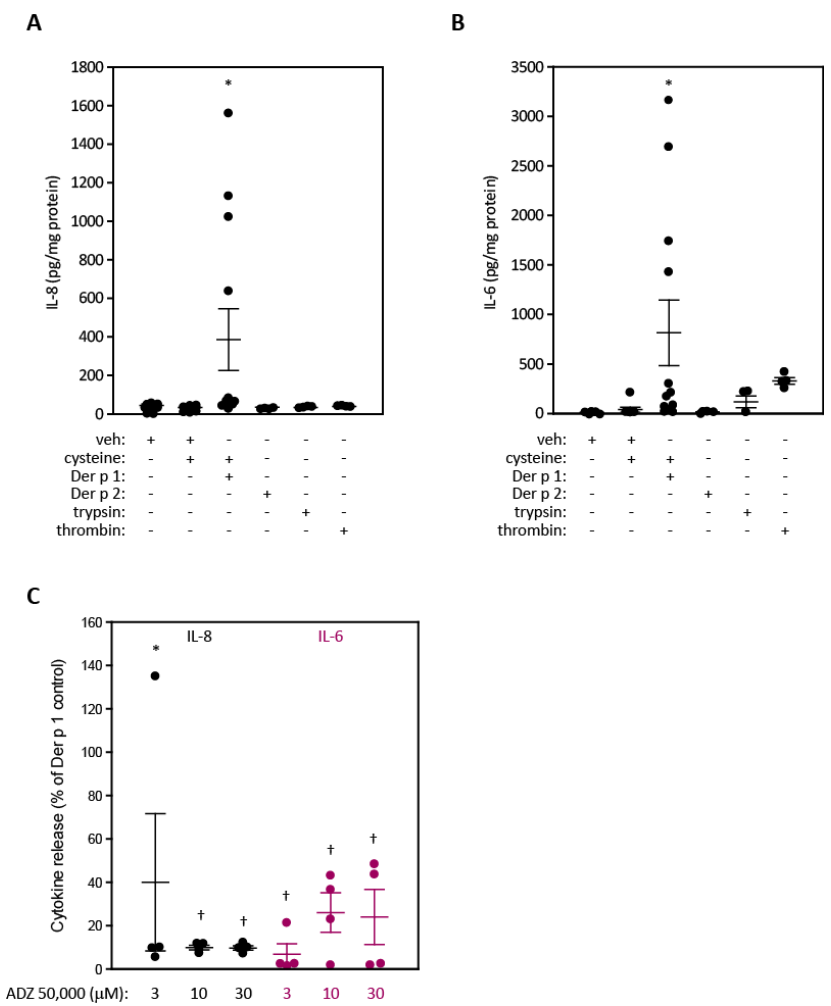
Figure 3. Release of IL-8 or IL-6 from cultured A549 cells and the effect of ADZ 50,000. ( A , B ) Release of IL-8 or IL-6 following stimulation by Der p 1 (20 nM), Der p 2 (14 nM), TPCK-treated trypsin (9 nM), or thrombin (0.5 U/mL) all applied apically. Cells were exposed for 8 h to serum-free EMEM containing the treatments, supplemented with 5 mM cysteine in the case of Der p 1. Cells were then washed and incubated with serum-free EMEM alone for a further 16 h prior to collection of samples. Data are shown as results from individual experiments with cells of different passage number. * p < 0.05 vs. vehicle treatments in experiments where cells were designated as responders. ( C ) Effect of ADZ 50,000 treatment on cytokine release (IL-8, black; IL-6, red) elicited by Der p 1 in designated responder experiments. Data from individual experiments are shown. * p < 0.05, † p < 0.01 vs. corresponding inhibitor-free control. In all cases, cross-hairs and whiskers denote mean ± s.e. mean, respectively.